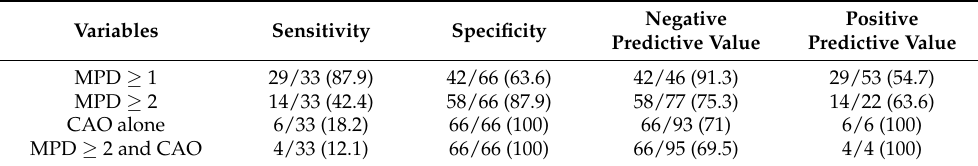
Table 5. Accuracy of the diagnosis of acute myocardial infarction on non-ECG gated chest CT according to retrospective CT grading of myocardial perfusion defect or artifact, with addition of coronary artery occlusion.